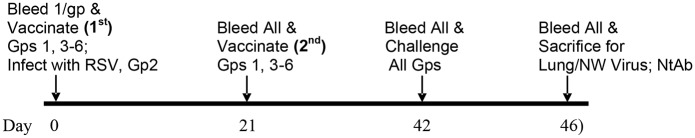
Vaccination schedule and experimental design.Thirty CRs (5 CRs/group; 6 groups), ~75–150 gm body weight were used. Body weight and sex distribution was similar across all groups. For subcutaneous (SC) vaccinations, 200 μL of vaccine was injected (using a tuberculin syringe) into subcutaneous space of the neck area. For intramuscular (IM) vaccinations, 100 μL of vaccine or diluent was injected (using a tuberculin syringe) into the area of each tibialis anterior (TA) muscle. Challenge virus was administered intranasally (100 μL) after CRs were lightly anesthetized with isoflurane.